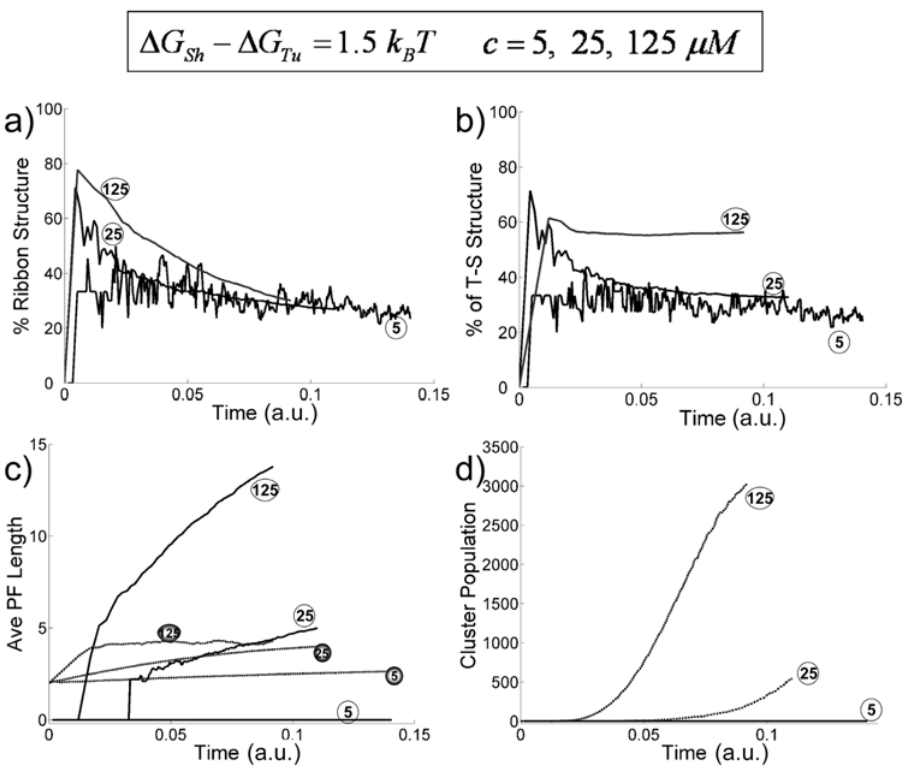
Figure 6. Effects of tubulin dimer concentrations on the assembly process (for D G SS ~~ 6 k B T , D G Sh ~~{{ 14 k B T , D G Tu ~~{{ 15 : 5 k B T , i.e., D G Sh {{ D G Tu ~~ 1 : 5 k B T ) (dimer concentration c=125, 25, 5 m M , as labeled in the figure with corresponding circled numbers). (a) Percentage of ribbon structures as a function of time. (b) Probability of finding neighboring T-S structures as a function of time. (c) Average PF lengths of structures with 1 PF (dashed lines with grey circled numbers indicating concentrations) and 5 PFs (solid lines with open circled numbers indicating concentrations) v.s. time. (d) Occurrence of clusters with 5 PFs v.s. time for different tubulin concentration as labeled.